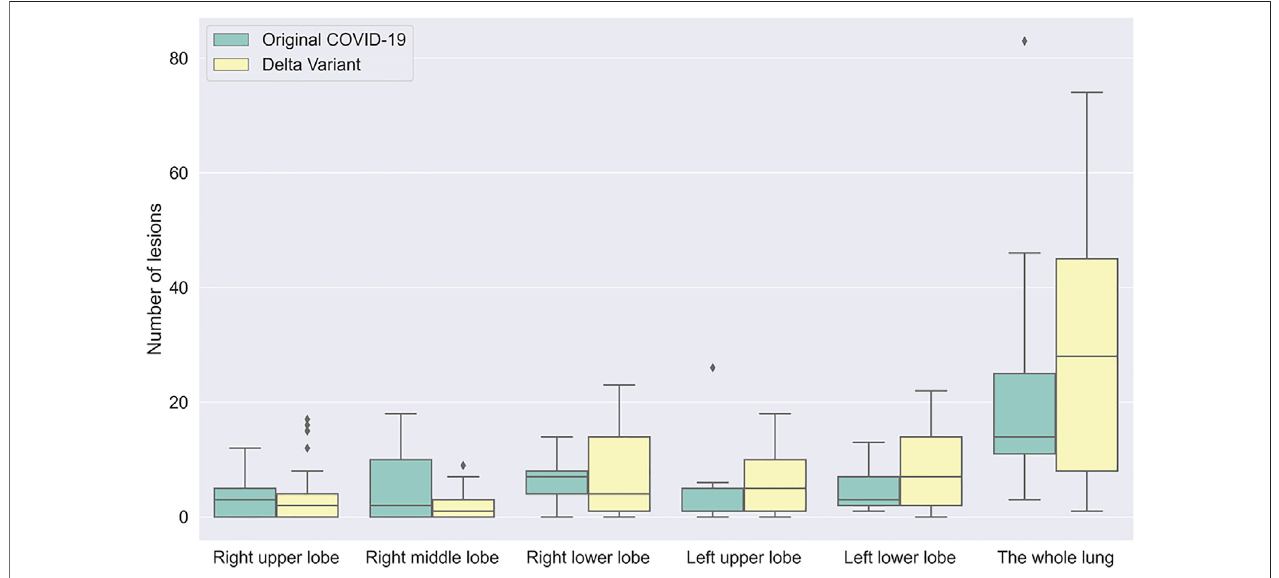
FIGURE8| AboxplotcomparingthenumberoflesionsinearlystageinpatientswithOriginalCOVID-19andDeltaVariant.Theabscissaindicatesdifferentregions, and the ordinate indicates the number of lesions. Early stages of Original COVID-19 and Delta Variant refer to 0 – 4 and 0 – 3 days,